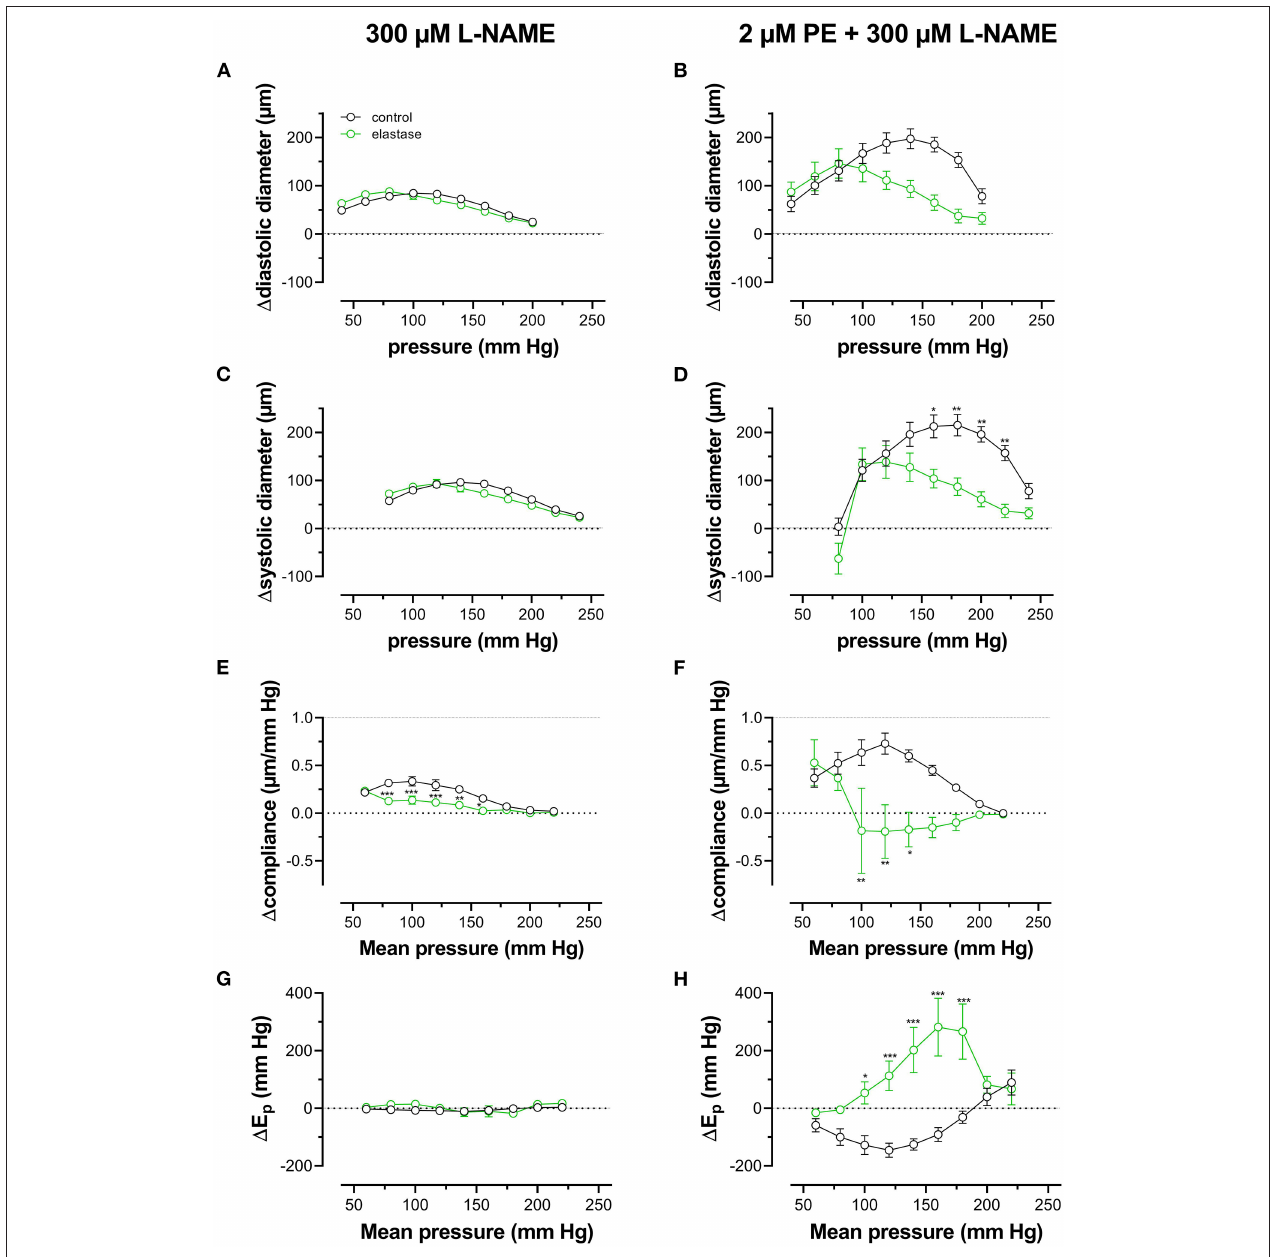
FIGURE 10 | Pressure-dependent hysteresis induced by contraction with PE is elastin dependent. Diastolic (A,B) and systolic diameters (C,D) , compliance (E,F) , and E p (G,H) were determined in untreated (black) and elastase-treated (0.1 unit/ml, green) aortic segments in KR (A,C,E,G) and in the presence of 2 µ M PE/300- µ M L-NAME (B,D,F,H) . Data points for the upward pressure steps were compared at any given pressure with data points for the downward pressure steps (stiffness hysteresis). Hence, positive values for diameter and compliance refer to larger diameters and compliance for downward pressure steps. Negative values for E p correspond to lower stiffness for the downward pressure steps (“de-stiffening”). Two-way RM ANOVA with Sidak’s multiple comparison test, * p < 0.05, ** p < 0.01, *** p < 0.001, n =